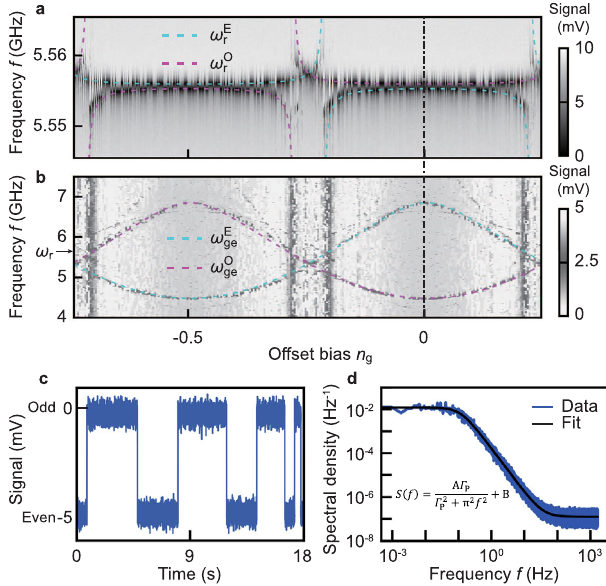
Fig. 2 | Spectroscopy and charge-parity detection. a Resonator ( ω r ) and b qubit spectroscopyasafunctionoftheoffsetchargebias n g ,showing2 e periodicityanda shift of 1 e between even and odd parity. The dashed lines are the identi fi ed reso- nator frequency ω E ð O Þ r and the g-e transition frequency of the qubit ω E ð O Þ ge (the superscriptletterEandOindicateevenandoddparity,respectively)from fi ttingto the Jaynes-Cumming model. The resonator spectrum was acquired by a network analyzeratarateof0.2speroffsetbiasorverticallinecut,whilethequbitspectrum was obtained from pulsed measurements with each data point taking ~0.1s. See Supplementary Note 3 (Supplementary Material) for the other identi fi ed transi- tions. c Exampleofthetimeevolution(timeinterval:0.3ms;totallength18s)ofthe charge parity measured at n g =0 showing random telegraph behaviour between even ( P =1) and odd ( P = − 1) parity. d Power spectrum of the charge-parity fl uc- tuations obtained from 1200 repetitions of the measurement in c . The inset shows the Lorentzian fi tting function, where Γ P (the average switching rate), A and B are fi tting parameters. In the illustrated case, the extracted charge-parity lifetime T P =1/ Γ P =2.7s. The white noise (offset term B ) is due to the sampling